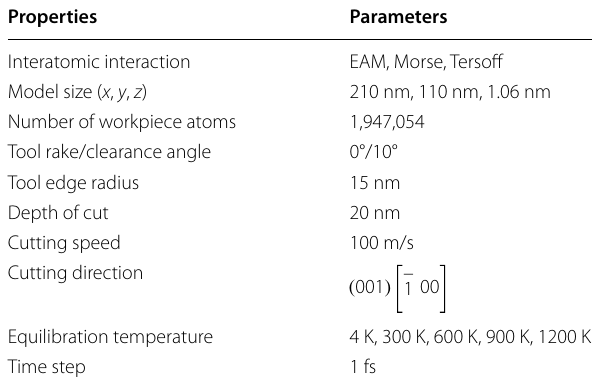
Table 2 Specific parameters of nano-cutting